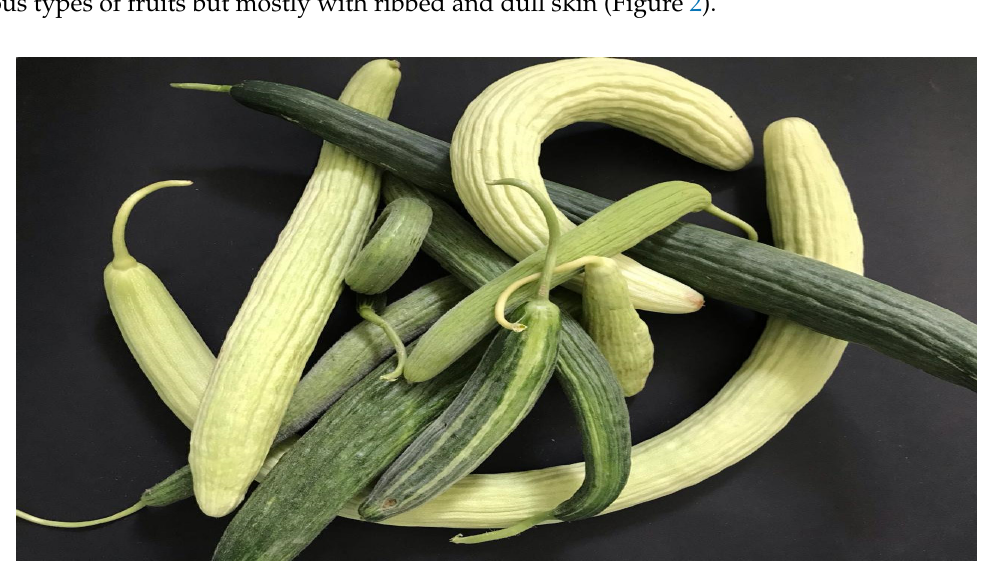
Figure 2. Morphological variation observed in some Lebanese snake melon accessions.